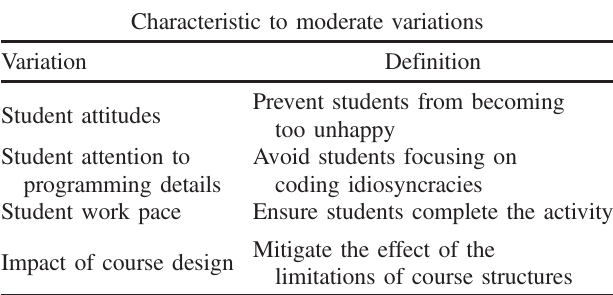
TABLE VIII. Variations within the characteristic to moderate theme, describing what aspects of a group ’ s experience a learning assistant feels they must monitor and influence.